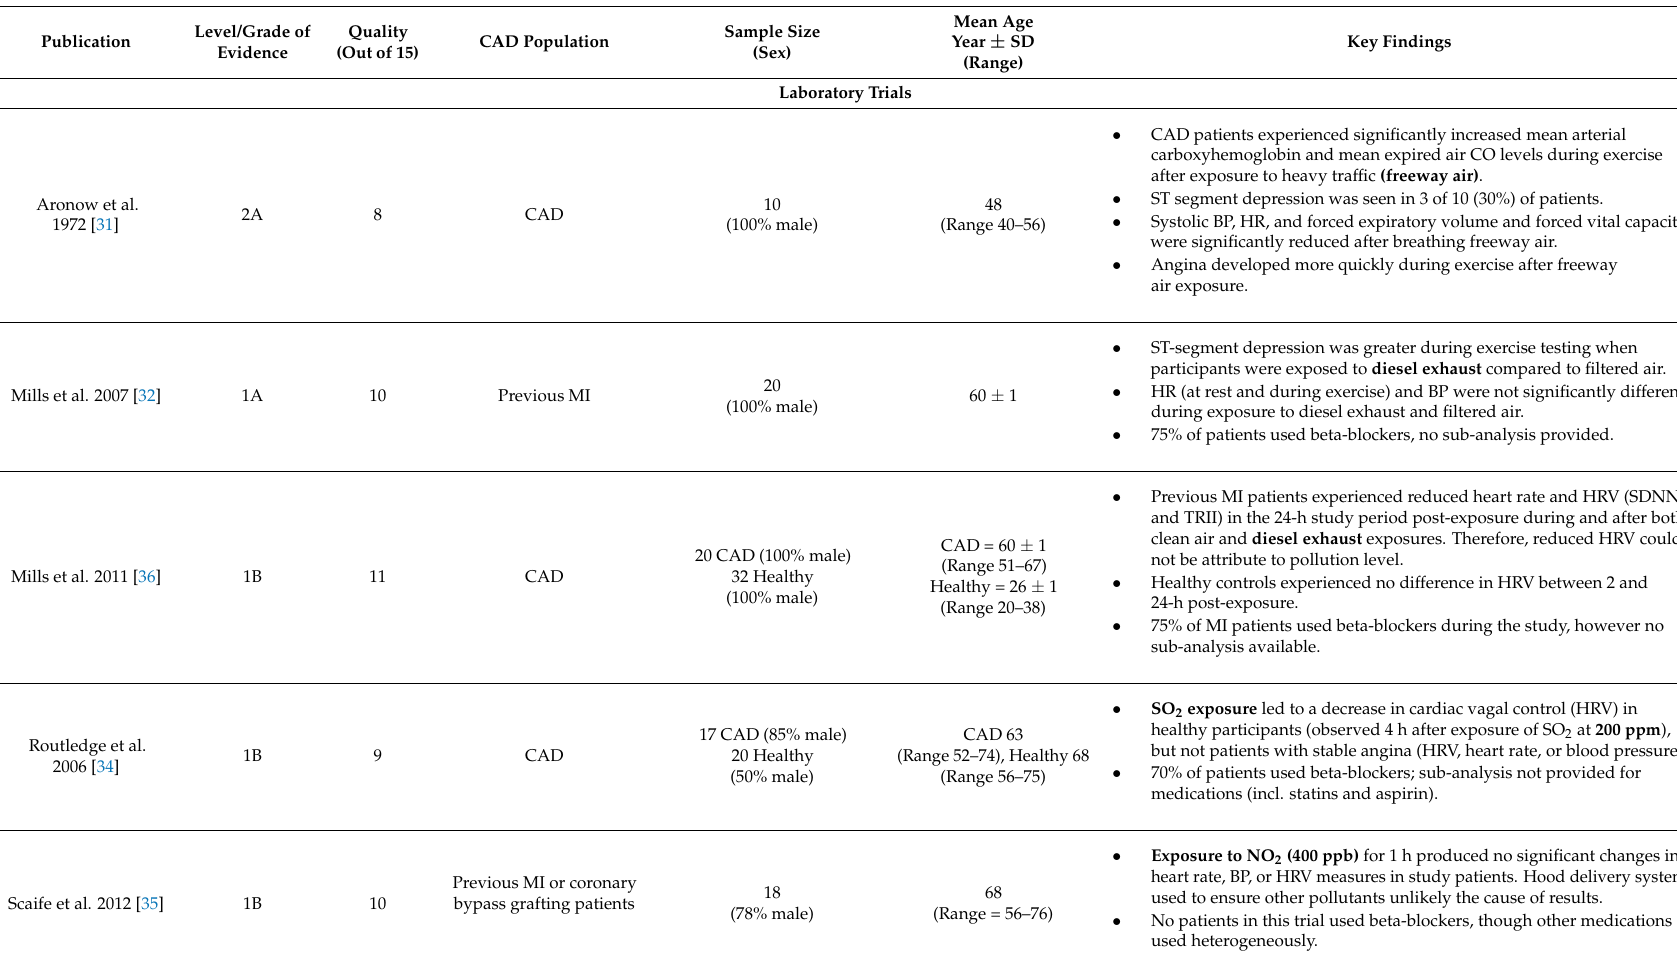
Table 4. Studies included in the review related to air quality and health risks in patients with coronary artery